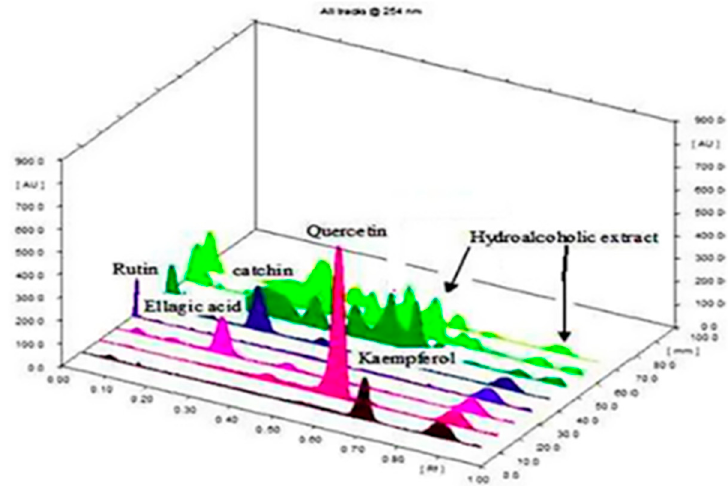
Figure 1. Simultaneous HPTLC profile of hydroethanolic extracts of P. maderaspatensis with different markers in the solvent system: toluene/ethyl acetate/formic acid/methanol (3:3:0.08:0.02) ( v / v ) at 254 nm. Table 1. TLC analysis of ethyl acetate fraction using different solvent systems and visualising agents. Sl. No.